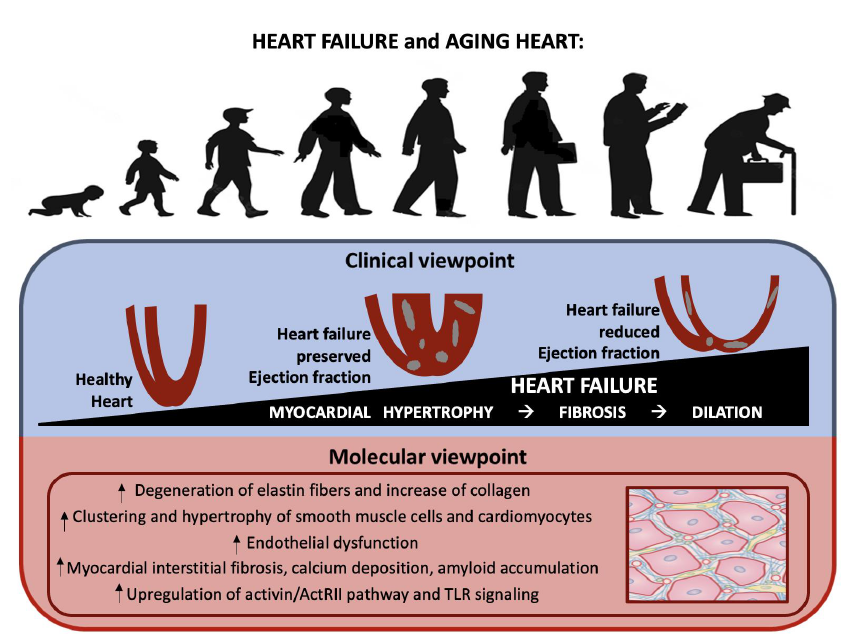
Figure 4. Aging heart and heart failure: from clinical to molecular viewpoint. Age-related myocardial hypertrophy due to multiple mechanisms (lower figure) results in fibrosis and subsequent cardiac dilation (upper figure).